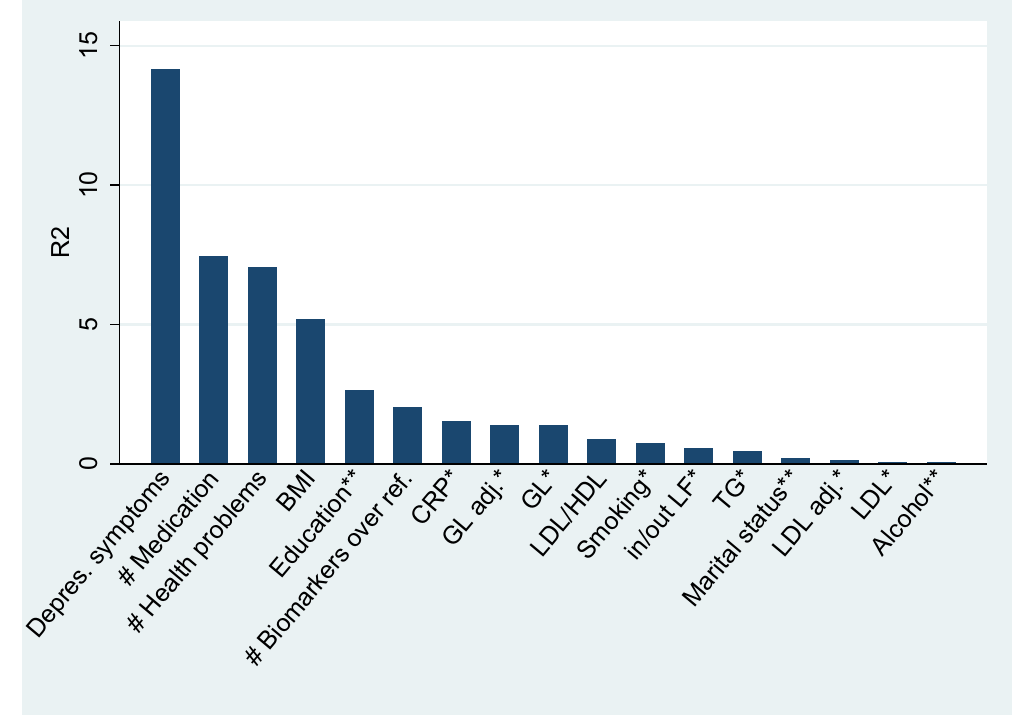
Fig 1. The proportion of self-rated health (SRH) variance (R 2 ) explained by each variable after controlling for age, sex, and location (N = 1021). Note: � binary indicator, �� categorical indicator, Adj. values = values adjusted for medication.